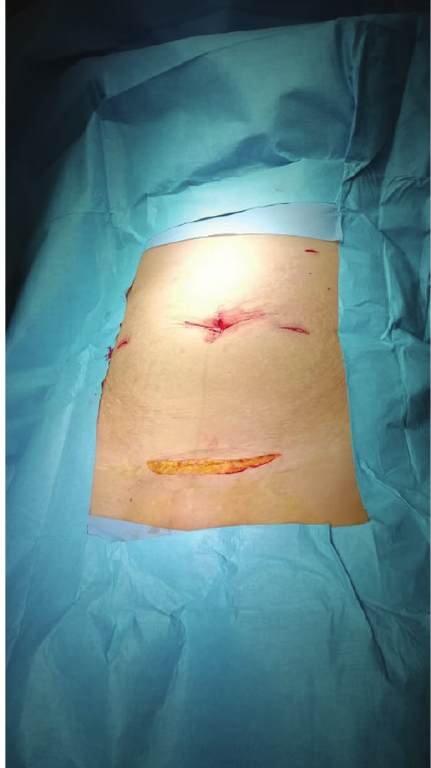
Figure 2: Pfannenstiel incision is used to deliver the specimen and perform urinary diversion. Table 1: Baseline patient